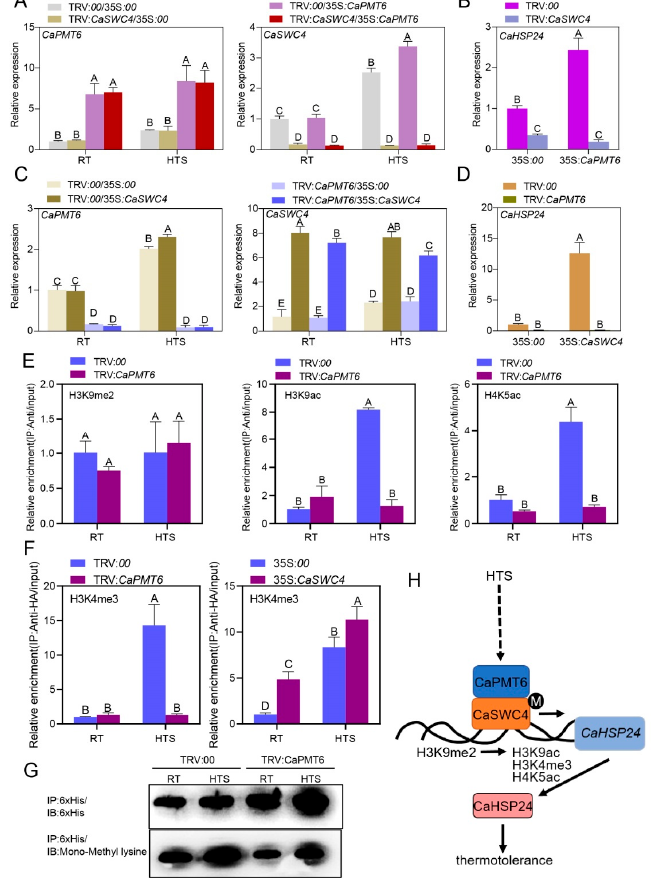
Figure 7. The functional relationship between CaPMT6 and CaSWC4 in modulating CaHSP24 expression. ( A ) The success of CaSWC4 silencing and transient overexpression of CaPMT6 by RT- qPCR in pepper plants. ( B ) The upregulation of CaHSP24 by transient overexpression of CaPMT6 was blocked by CaSWC4 silencing. ( C ) The success of CaPMT6 silencing and transient overexpression of CaSWC4 by RT-qPCR in pepper plants. ( D ) The upregulation of CaHSP24 by transient overexpression of CaSWC4 was blocked by CaPMT6 silencing. ( E ) The enrichment of H3K9ac and H4K5ac in the TSS of CaHSP24 was blocked by CaPMT6 silencing upon HTS by ChIP-qPCR. ( F ) The enrichment of H3K4me3 in the TSS of CaHSP24 by CaSWC4 transient overexpression upon HTS was blocked by CaPMT6 silencing by ChIP-qPCR. ( G ) The effect of CaPMT6 silencing on methylation of CaSWC4 under different environmental conditions: CaSWC4-6 × His was expressed in E.coli and mixed with proteins isolated from TRV2: CaPMT6 or wild type pepper plants under the conditions of RT (28 ◦ C, 80% humidity) or HTS (42 ◦ C, 80% humidity), and then CaSWC4-6 × His was immunoprecipitated with antibody of His, and the presence of CaSWC4-6 × His in the acquired protein was detected by immunoblotting with antibody of His, and the methylation of CaSWC4-6 × His was detected by immunoblotting using antibody of mono-methyl lysine. ( H ) Mechanism underlying CaHSP24 expression and, thus, tolerance to HTS mediated by CaSWC4-CaPMT6 module, CaPMT6 interacts with and methylates CaSWC4, thus turns on chromatin activation mediated by CaSWC4, and thus activates expression of CaHSP24 and defense response to HTS. In ( A , D) , CaActin was used as an internal control, the transcript levels of TRV: 00 /RT was set to 1; data are shown as means ± standard error of eight replicates; asterisks above the bars indicate significant differences among means ( p < 0.01), as calculated with t -test. In ( E , F ), The enrichment levels of the tested genes were compared with those in the control, and the relative enrichment of IP using antibody/TRV: 00 was set to a value of 1 after normalization by input; data are shown as means ± standard error of three replicates. Different uppercase letters above the bars indicate significant differences between means ( p < 0.01) by Fisher’s protected LSD